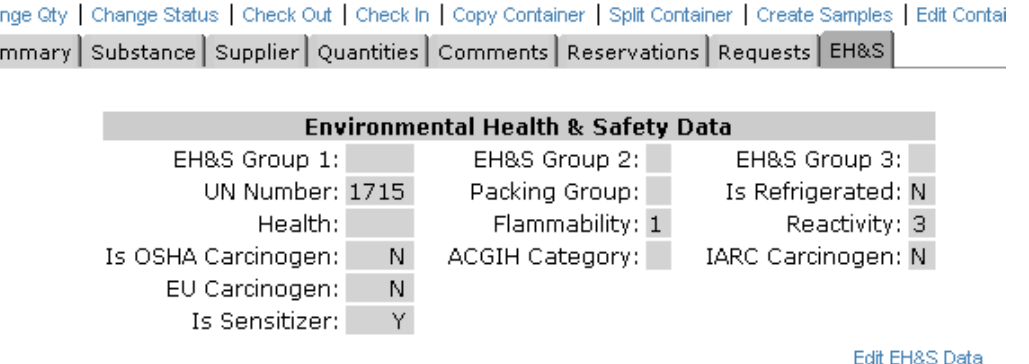
FIGURE 10: EHS data